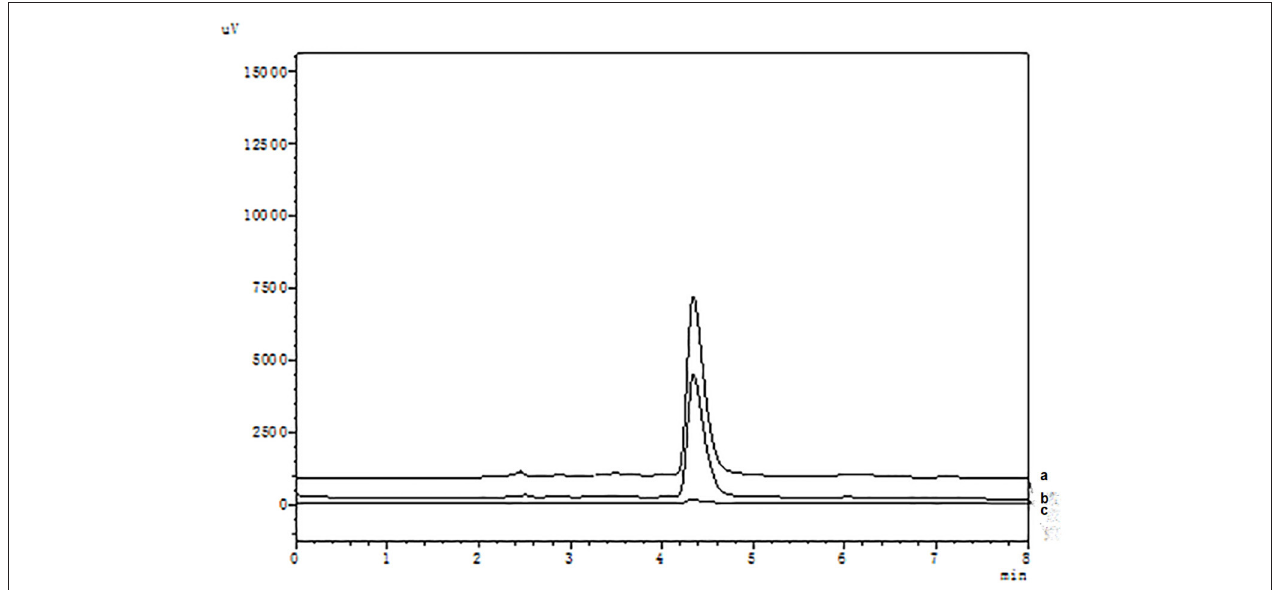
FIGURE 2 | High-performance liquid chromatography (HPLC) chromatograms of celecoxib (a) and ligand fishing assay eluent by SMGO-COX-2 (b), and SMGO (c).